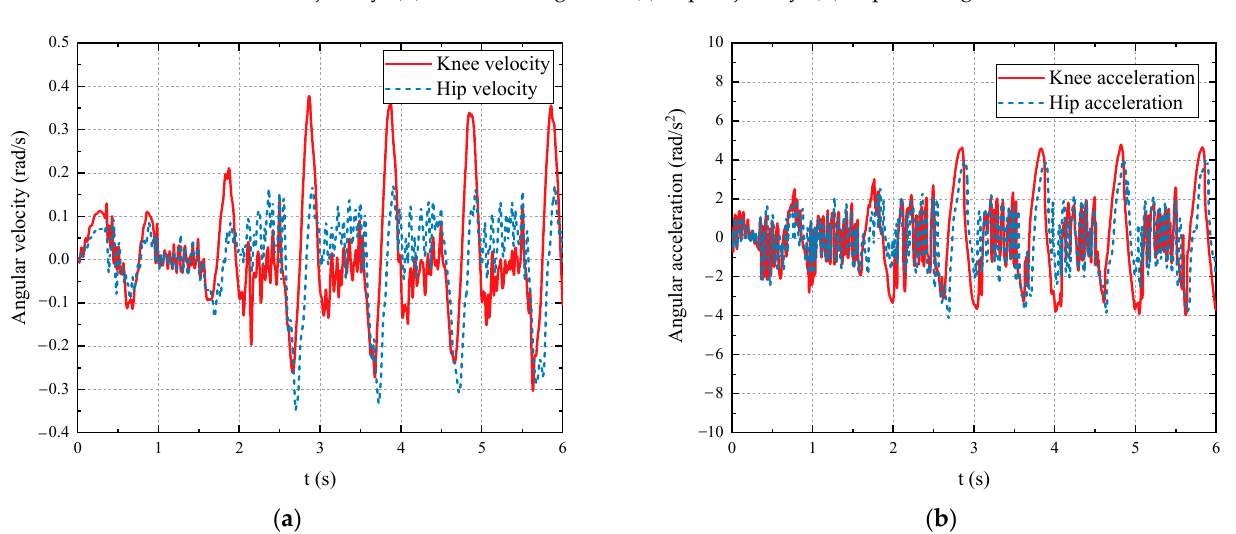
Figure 10. The velocity and acceleration of knee and hip through HOSMD: ( a ) Knee and hip angular velocity; ( b ) Knee and hip angular acceleration.